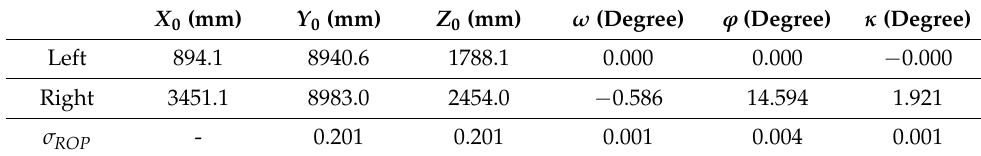
Table 1. Scale-adjusted ROPs of the cameras in two cases.